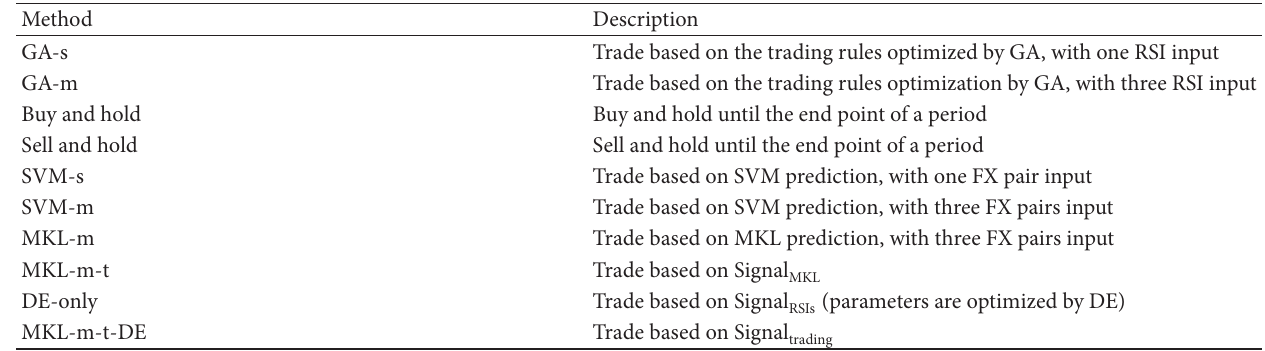
Table 9: List of the methods tested.